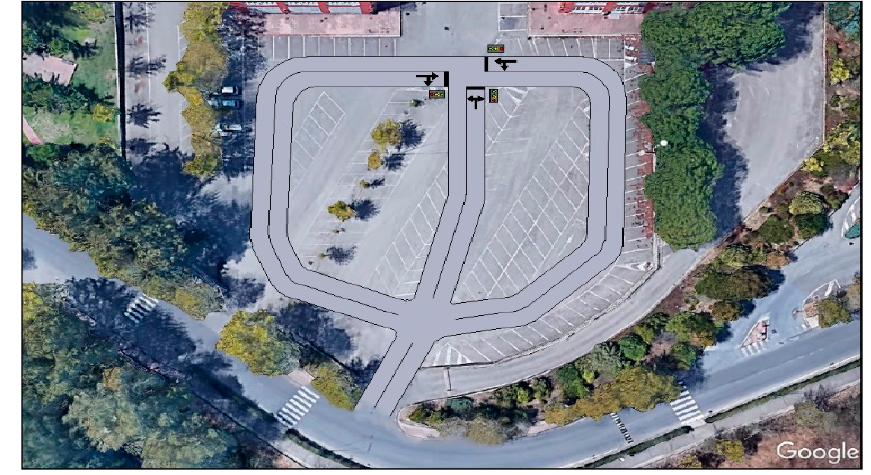
Figure 5. The experimental site: a three-legs intersection.